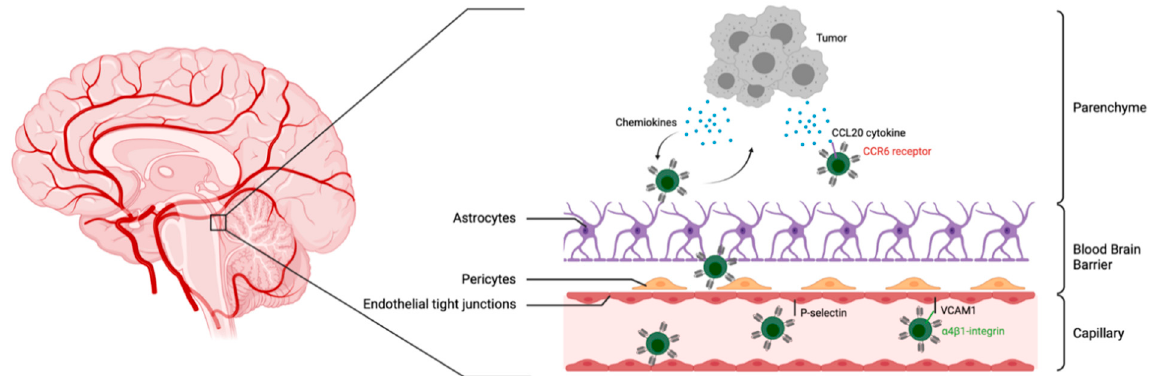
Figure 2. CAR T cell migration across the blood–brain barrier in pediatric brain tumors. Bottom: Tight junctions between endothelial cells limit the passage of CAR T cells. Interaction with P-selectin decreases T cell velocity in capillaries. Integrin α 4 β 1 receptor engagement by VCAM1 proteins expressed by endothelial cells initiates T cell arrest followed by T cell diapedis. Middle: Pericytes and astrocyte endfeet further impede T cell trafficking into the brain parenchyma. Top: Tumor cells within the brain parenchyma may recruit T cells through chemokine production as indicated.